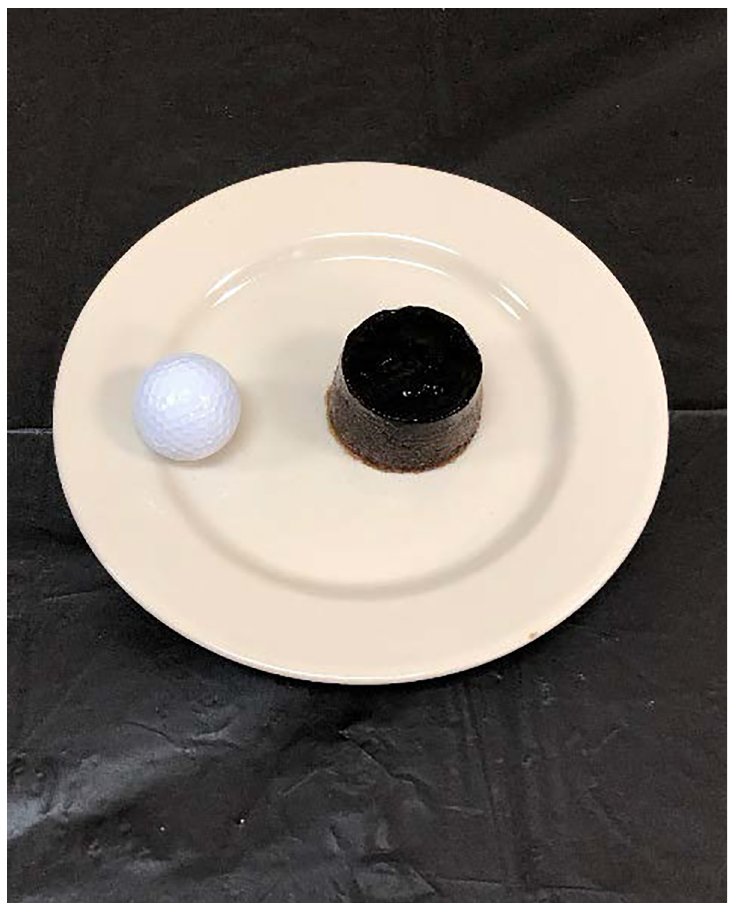
Fig 2. The Sugar Sweetened Solid (SSS). The golf ball provides